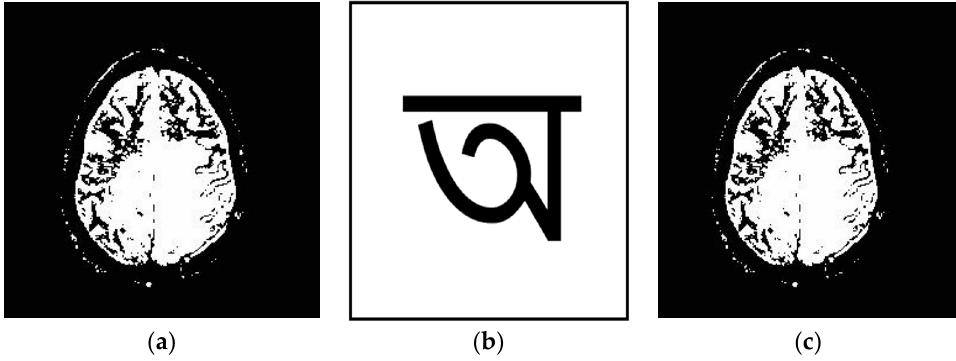
( b ) Figure 6. ( a ) Structure of second level DWT, ( b ) Second level DWT of the image. 4. Experimental Results